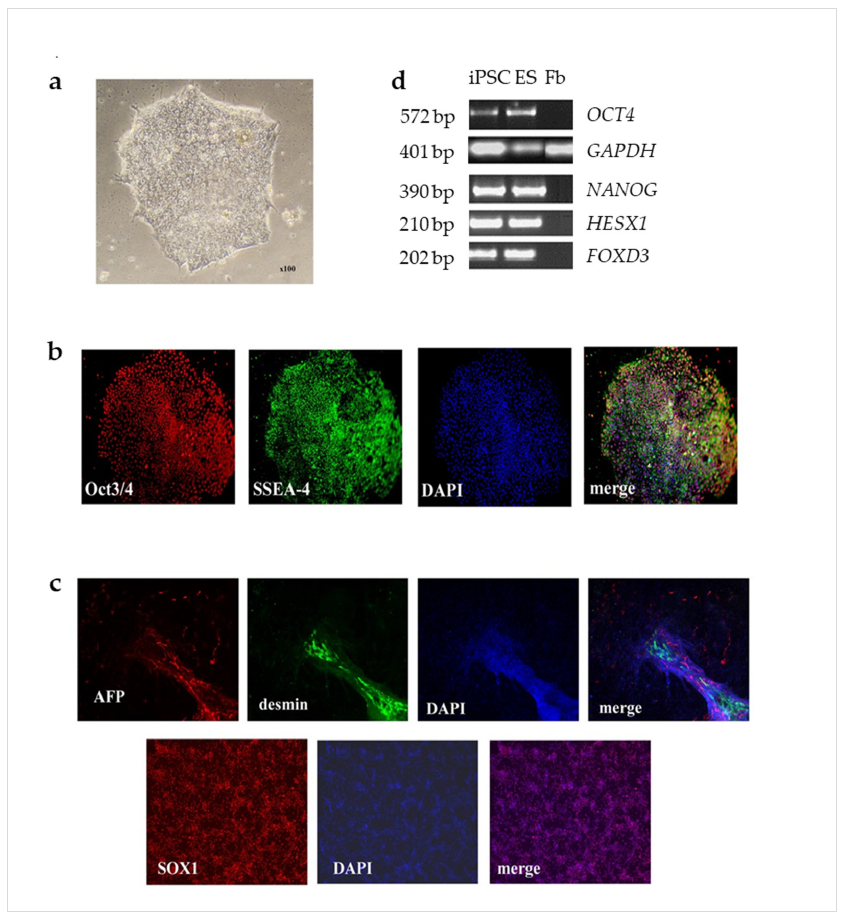
Figure 7. Immunocytochemical staining of obtained iPSC cells. ( a ), typical normal morphology for human pluripotent stem cell; ( b ), the iPSC line demonstrated positive immunofluorescent staining for key transcriptional factor OCT3/4 (red) and surface marker SSEA4 (green); nuclear staining DAPI (blue). ×100; ( c ), the pluripotency was proved by the formation of embryonic bodies, which contained tissues from three germ layers: ectodermal (SOX1—red), mesodermal (desmin—green) and endodermal (AFP—red); nuclear staining (DAPI—blue). ×100; ( d ), the qPCR results demonstrating that OCT4 , NANOG , HESX1 , and FOXD3 were expressed in iPSC at a similar level compared to ES (positive control) and were not expressed in fibroblasts (negative control).